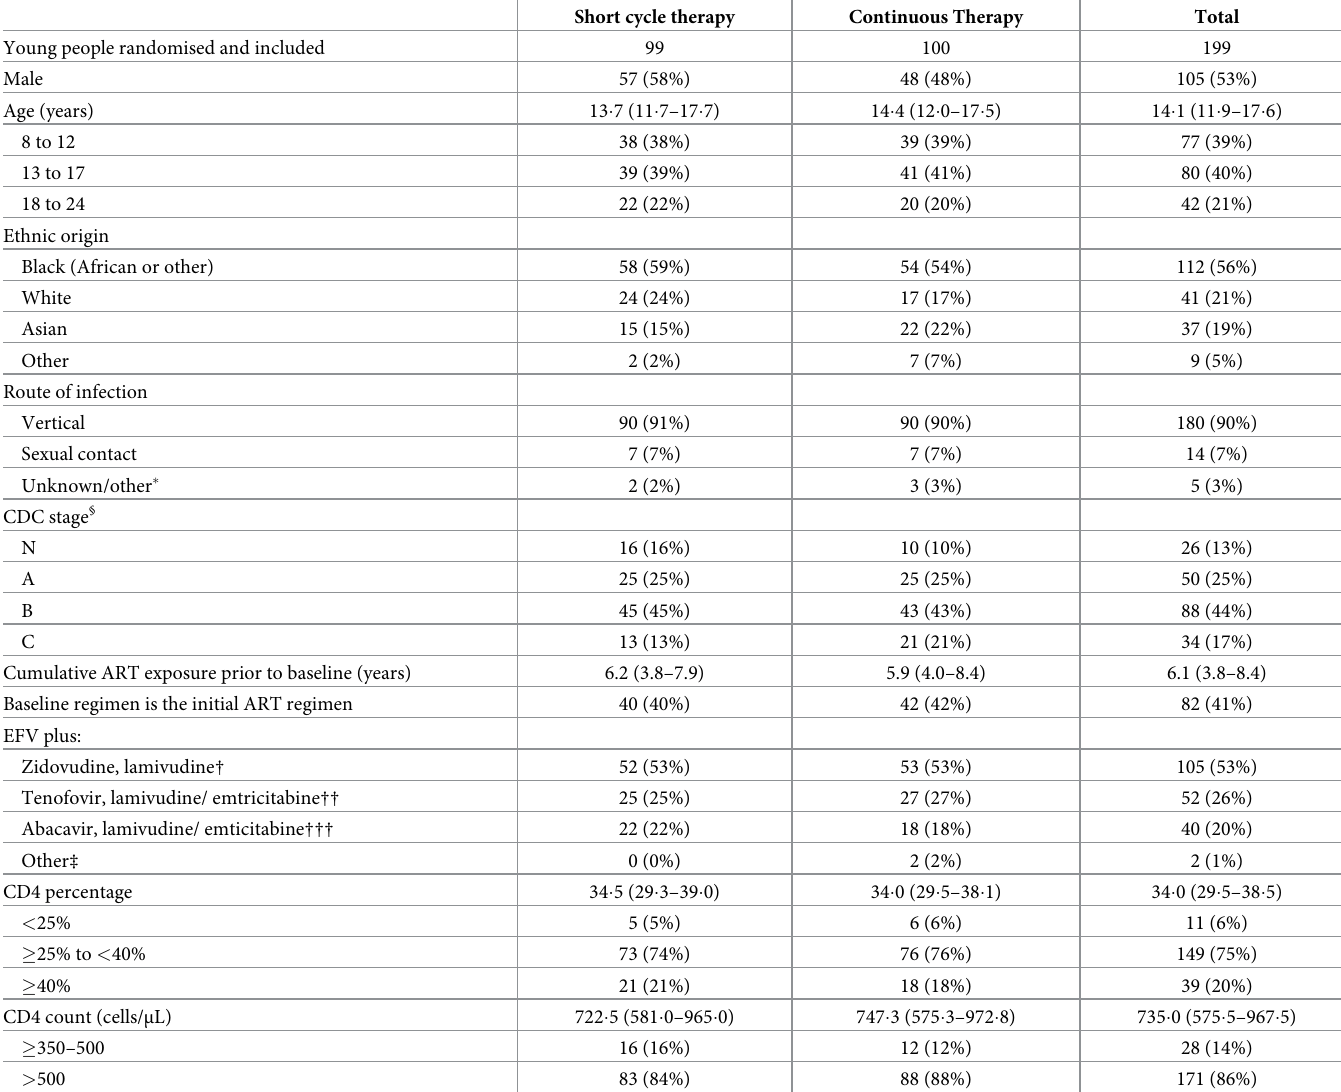
Table 1. Baseline